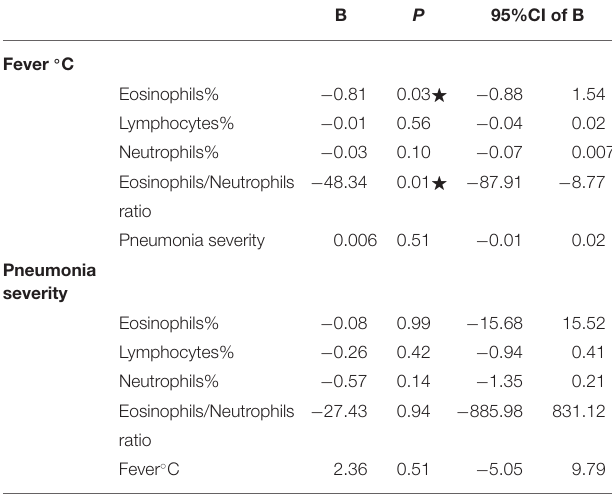
TABLE 3 | The correlation of fever and Pneumonia severity and four indexes (Linear